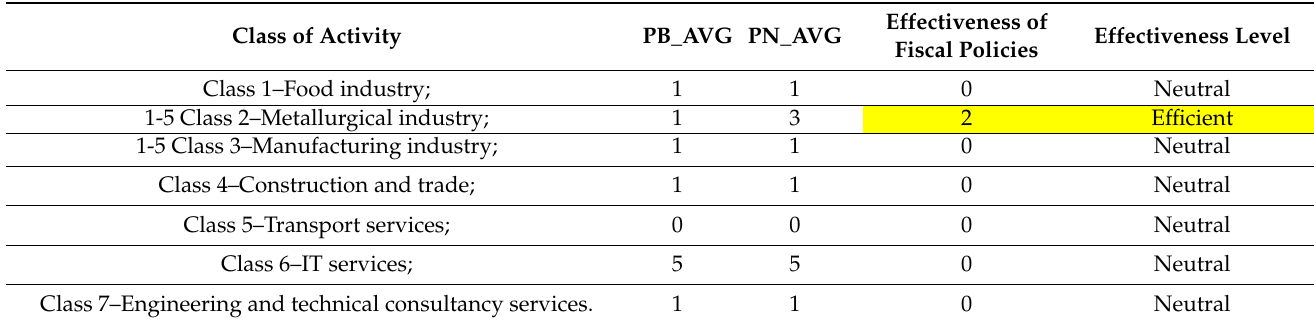
Table 3. Evaluating the effectiveness of fiscal